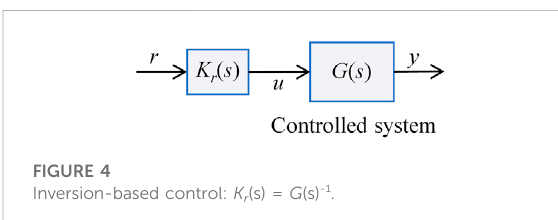
FIGURE 4 Inversion-based control: K r (s) = G (s) -1 .